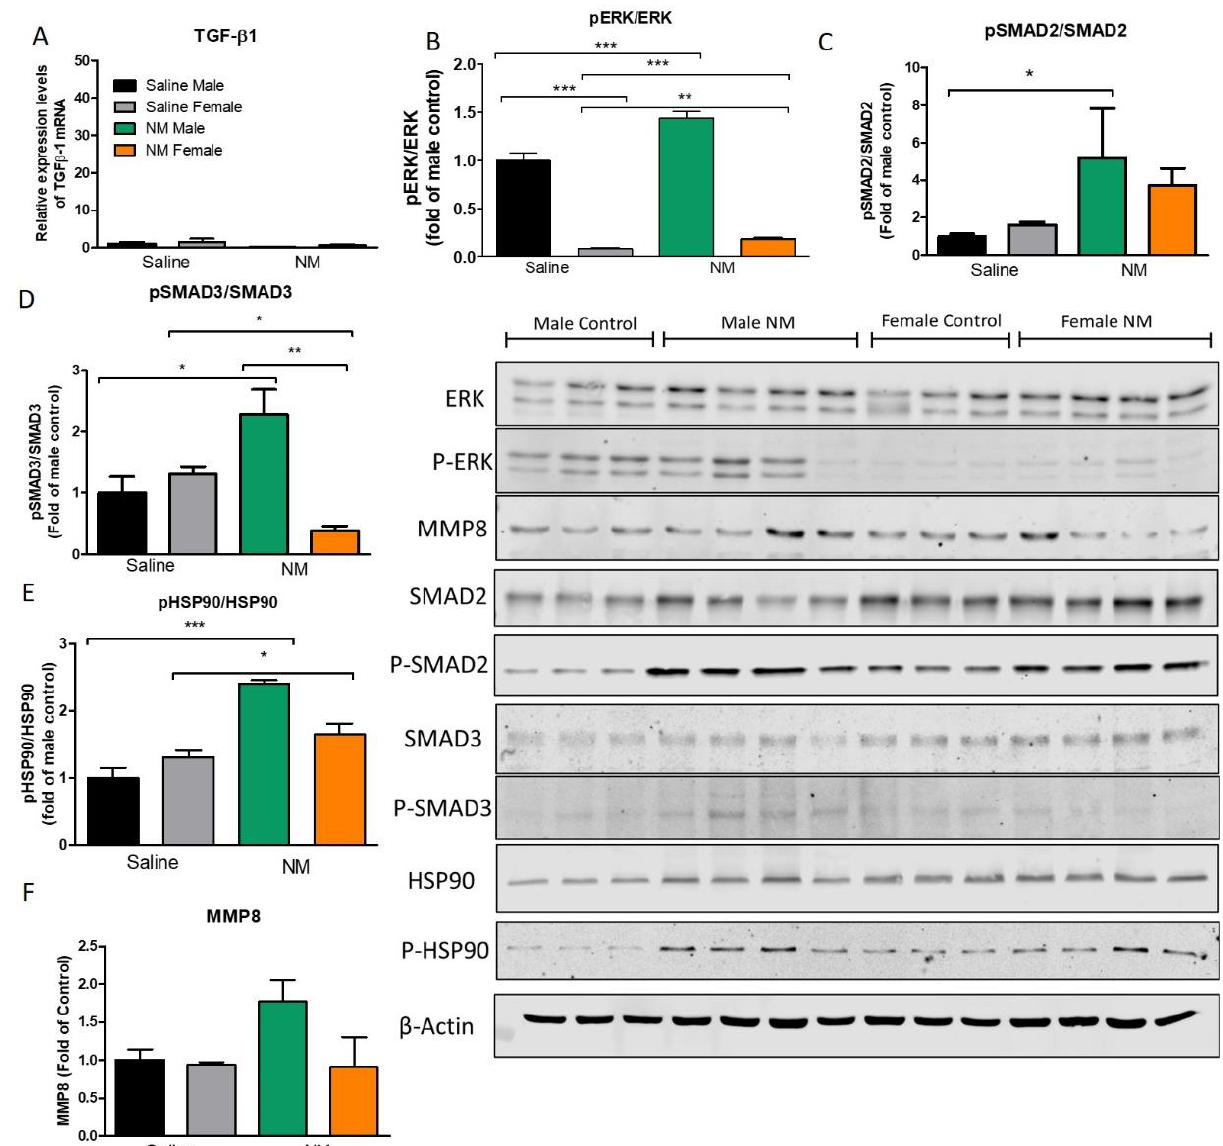
Figure 5. Intracellular pathways of TGF- β activation 30 days after NM instillation. ( A ) No changes were observed in the expression levels of isoform 1 of TGF- β between males and females instilled with NM. ( B ) Male mice treated with NM displayed increased levels of p-ERK compared to females. ( C , D ) SMAD2 and SMAD3 were activated only in males. ( E ) Heat Shock Protein 90 activation (pHSP90) increased only in males. ( F ) Matrix Metalloproteinase levels were not significantly altered. TGF- β 1 mRNA expression levels were measured by real-time qPCR and normalized to β -actin. Band density was normalized to β -actin and plotted as fold of control. Means ± SEM; *** p < 0.001, ** p < 0.01, * p < 0.05 with one-way ANOVA and Tuckey’s, n = 3 – 4.